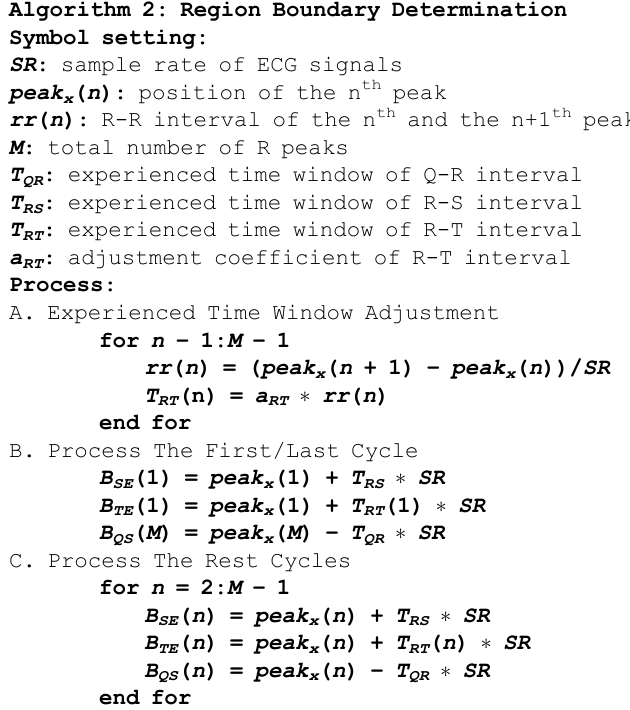
Algorithm 2: Region Boundary